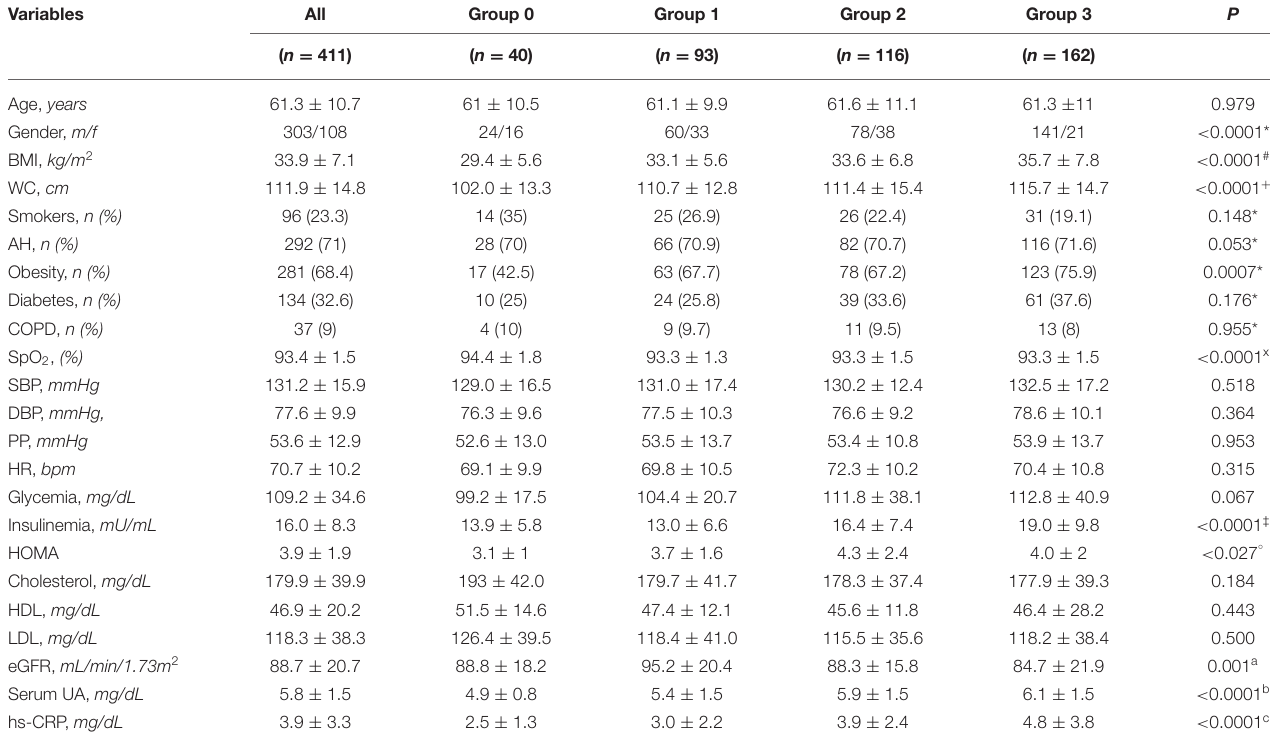
TABLE 1 | Anthropometric, hemodynamic and biohumoral characteristics, stratified according to AHI values. Variables